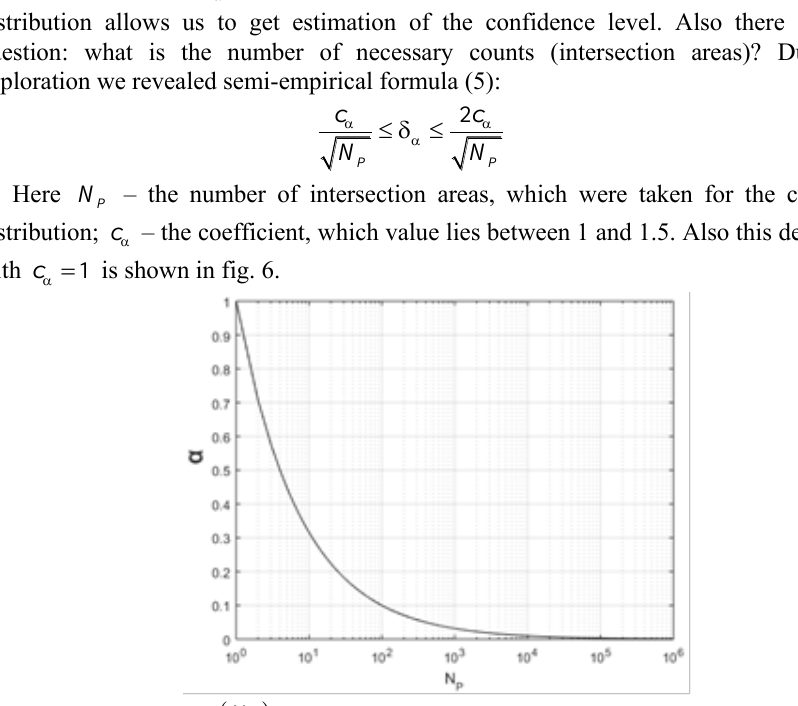
N  for choosing the necessary P